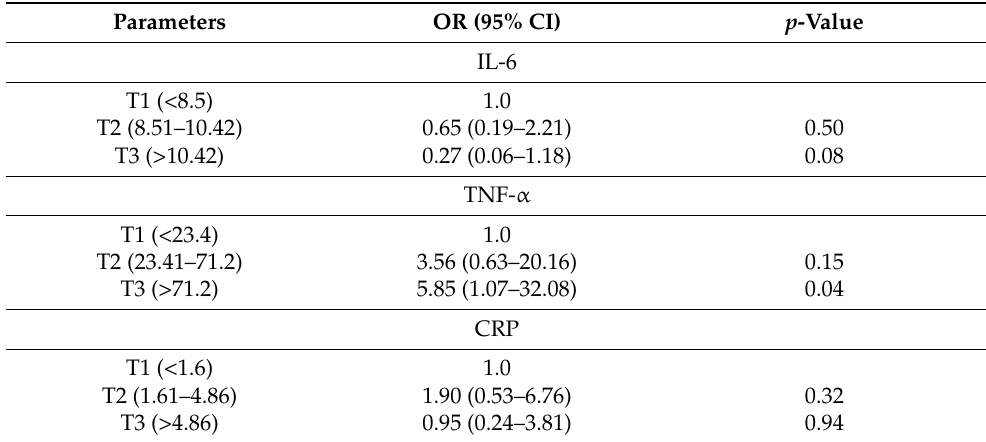
Table 6. Logistic regression analysis using inflammatory marker cut-offs to determine predictive power in identifying those with